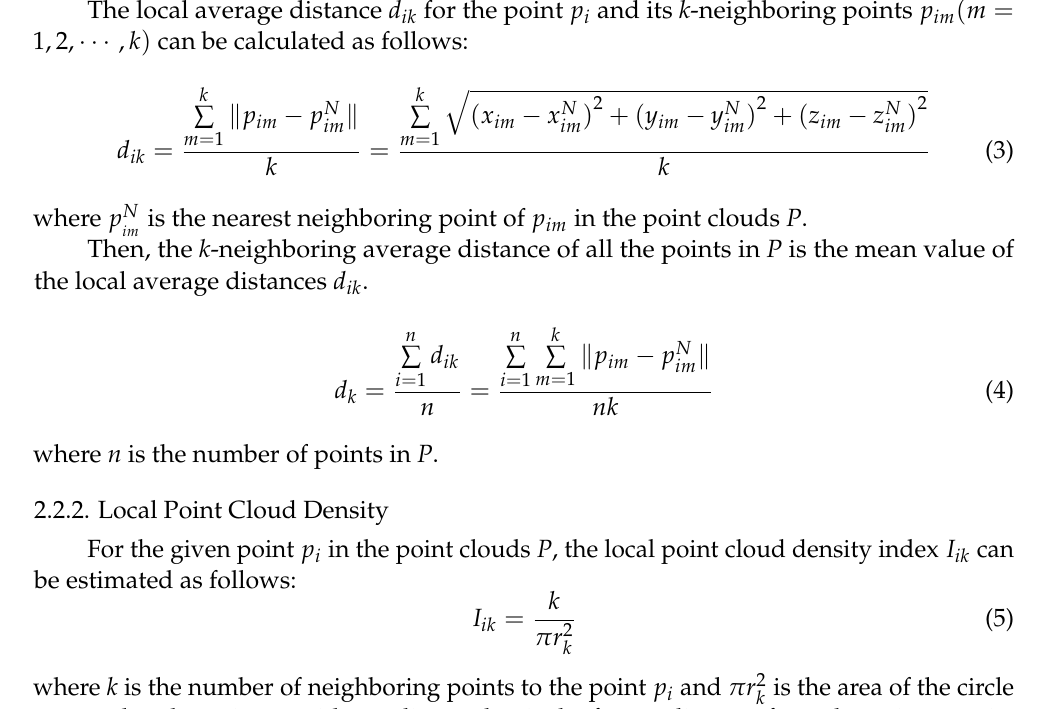
Figure 1. A point p i and its k -neighboring points p im ( m = 1,2, · · · , k )